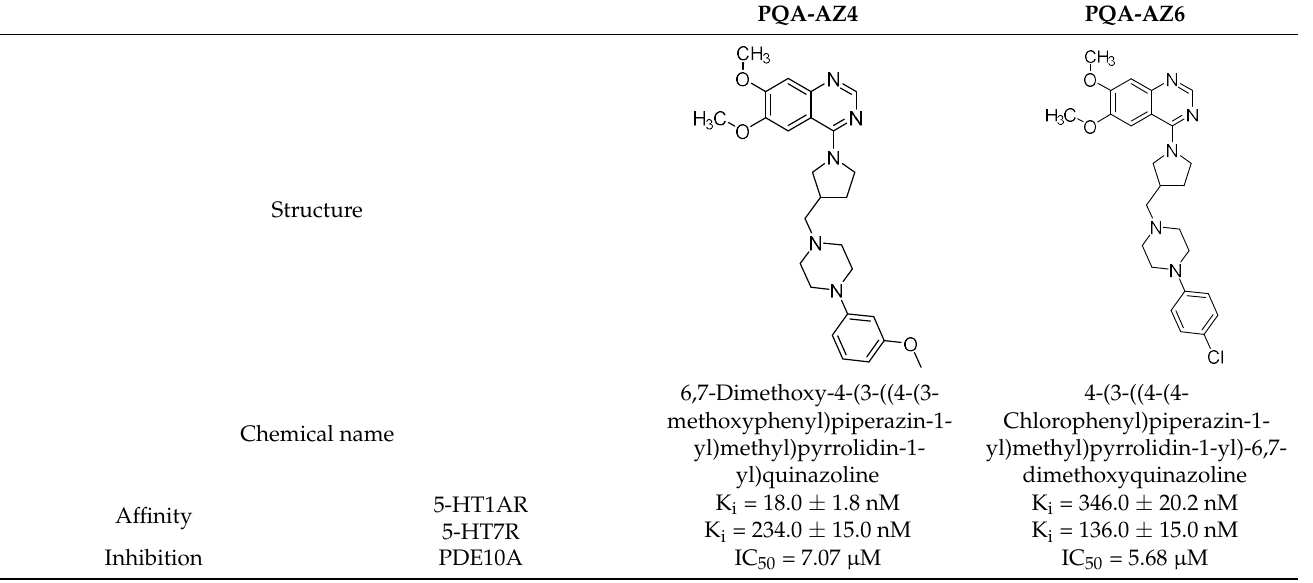
Table 1. Structure and binding profile of compounds PQA-AZ4 and PQA-AZ6.